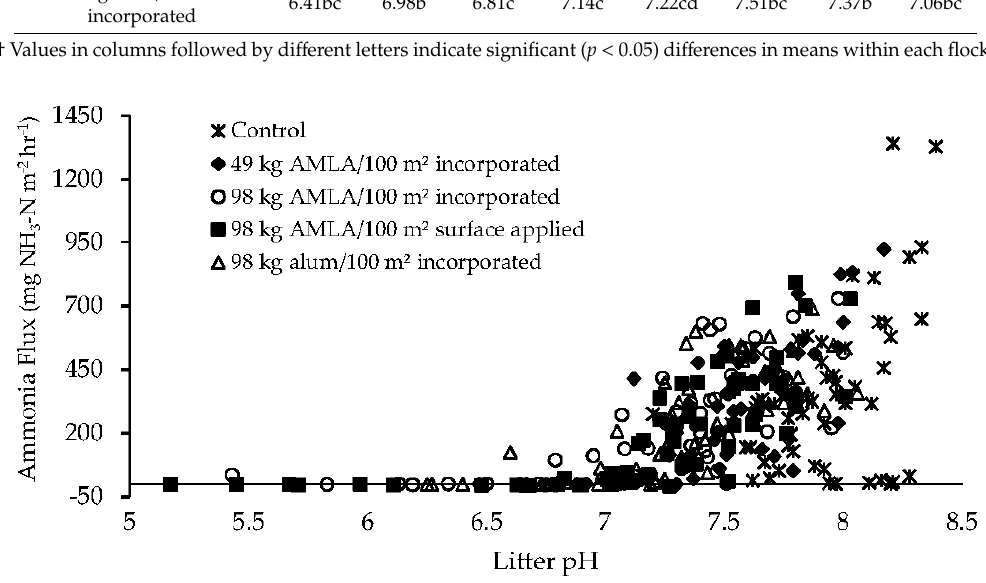
Figure 3. Ammonia flux (mg NH 3 -N m − 2 hr − 1 ) as a function of litter pH.